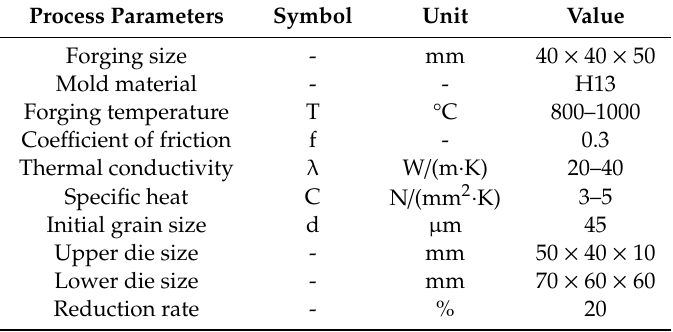
Table 5. Parameter